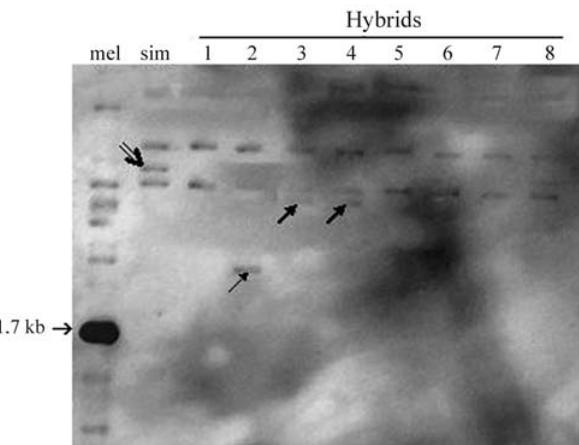
Figure 3 - Hybridization of 703 bp probe homologous to Bari-I internal sequence with genomic DNA of Drosophila melanogaster , D. simulans and hybrids strains after cleavage with Hind III restriction endonuclease. Lanes are as follows: mel, D. melanogaster IN(1)AB; sim, D. simulans C167.4;1-8,SM 1 toSM 8 ,respectively.Thinarrowshowbandnotfoundin D. melanogaster or D. simulans but present in SM 2 hybrid strain. Thicker arrows show bands in SM 3 and SM 4 hybrid strains and in D. melanogaster but no in D. simulans . Double arrow shows band found in D. simulans but absent in SM 1 to SM 7 hybrid